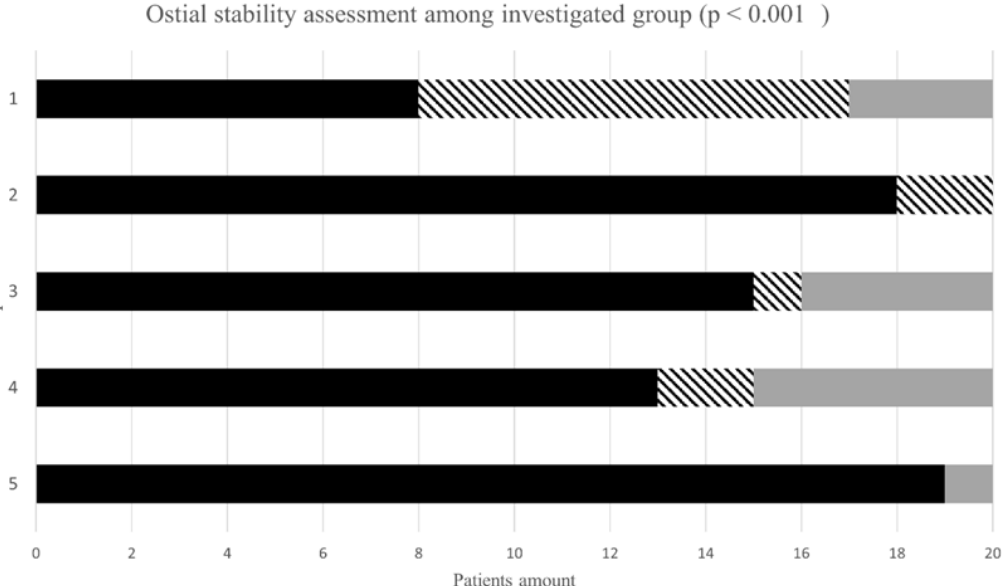
Figure 2. Ostial stability assessment among investigated groups. Figure legend: black — optimal stability; striped — subop- timal stability; gray — necessity to change catheter.